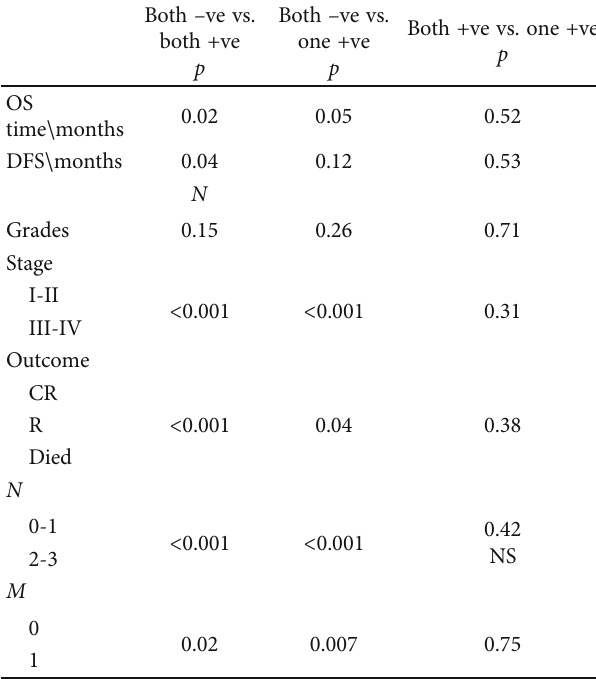
Table 4: Multiple comparisons. Table 5: Association between CTCs and basic characteristics among studied